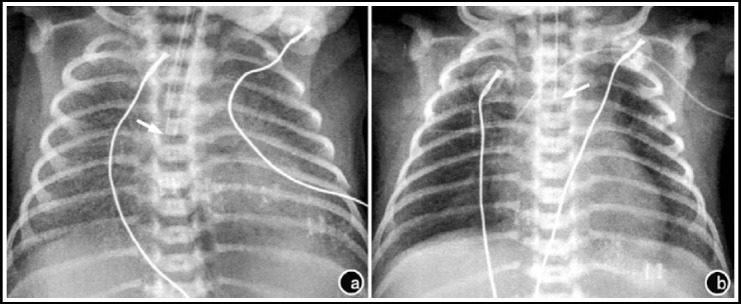
Pulmonary X-ray results of neonate No. 2 before and after treatment. a) 50 minutes after birth, before treatment; b) 8 hour after PS treatment.